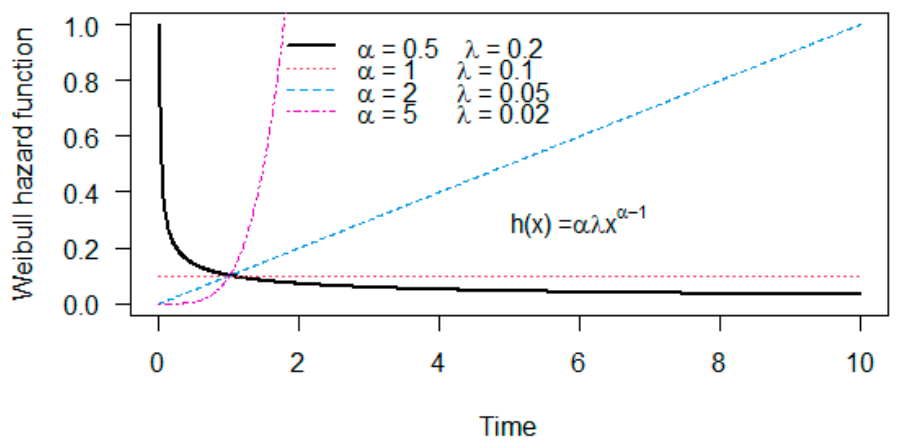
Figure 3. Hazard functions for the Weibull distribution with parameters 𝜆 and 𝛼 .